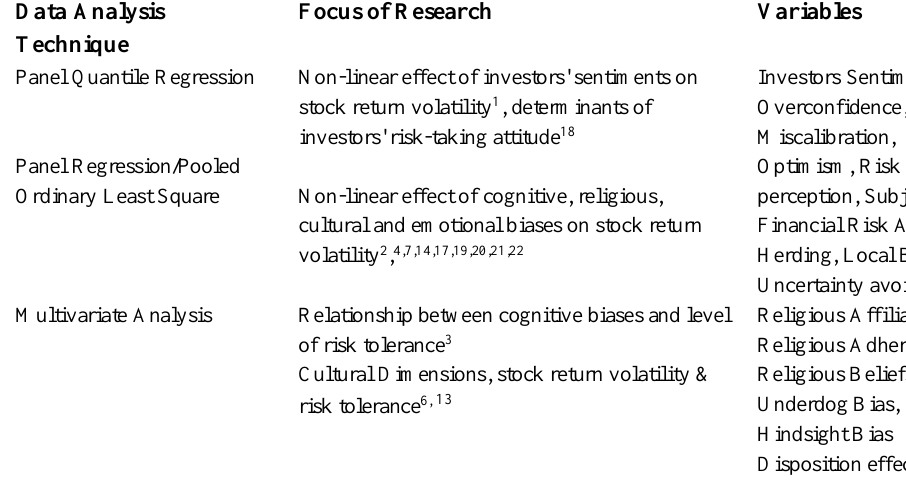
Table.3. Statistical Techniques/ Data Analysis